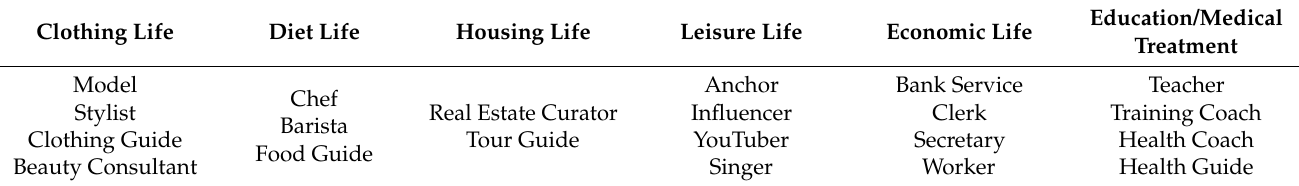
Table 2. Digital human by occupation in terms of lifestyle